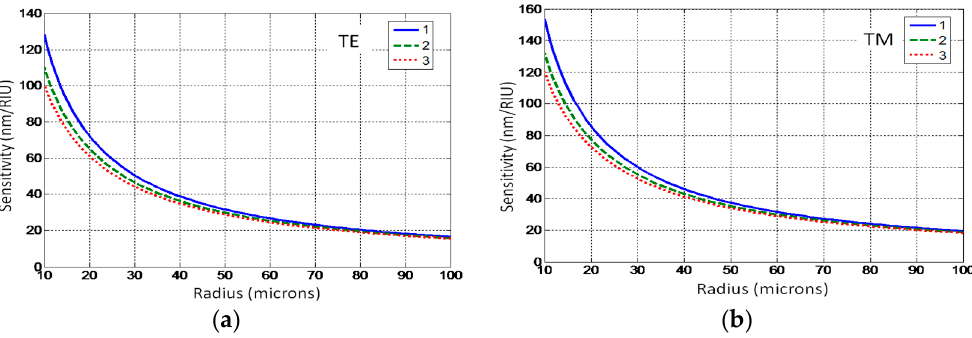
Figure 4. The sensitivity of the bottle resonator sensor as a function of the fiber radius for ( a ) the TE and ( b ) the TM polarized WGMs. p = 1, 2, and 3.